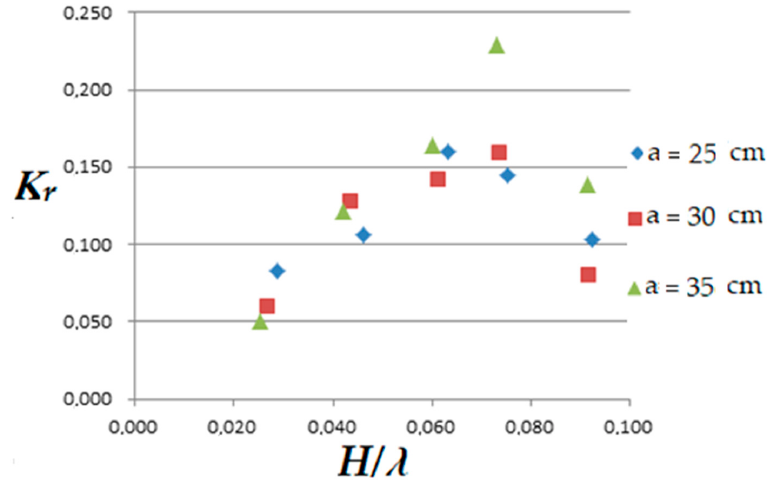
Figure 9. The relationship between wave steepness and transmission coefficient at different water Figure9. Therelationshipbetweenwavesteepnessandtransmissioncoe ffi cientatdi ff erentwaterdepths. depths.